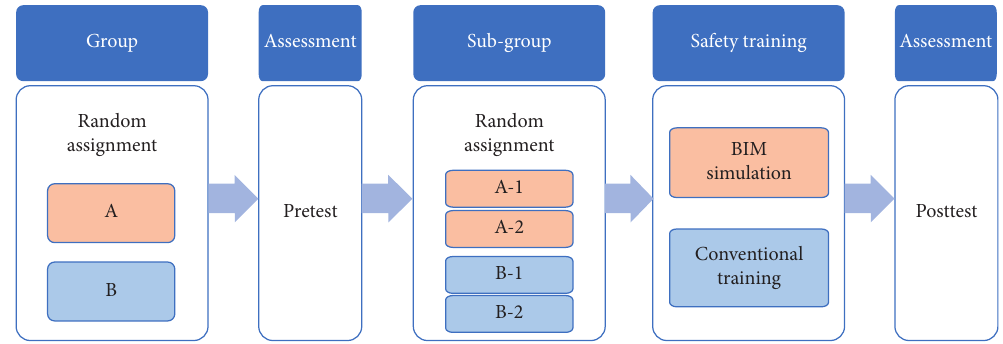
Figure 4: Process of safety training and the assessment by groups. Table 2: t -test result of pretest and posttest of each group.